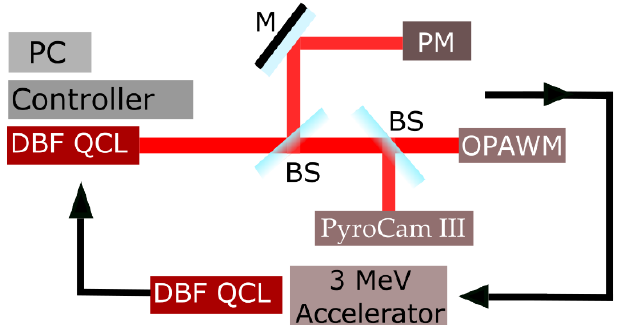
Figure 1. The sketch of the QCL testing setup, including: the current and temperature controller; DBF-QCL; PyroCam III; Power meter (PM); Optical spectrum analyzer and wavelength meter (OSAWM); Computer—PC; Mirror (M) and two Beam-splitters (BS). After the initial characterization, the QCL was irradiated using the 3 MeV accelerator, followed by another set of characterizations.